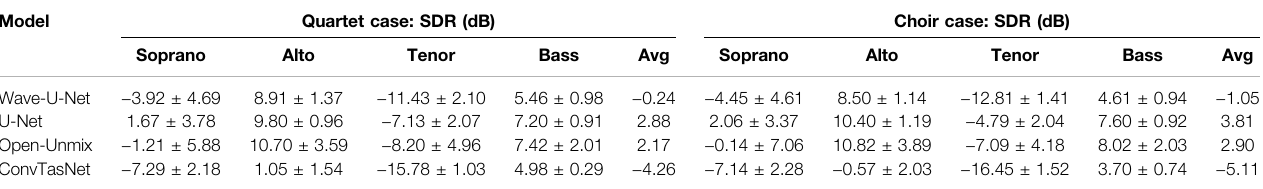
TABLE4| SDRresultsfrom modelname_CBDE evaluatedonECDsongs(13singerswithallthesingersinthemix),showingthetrainingwithdatafromthequartetcase(left) and choir case (right).